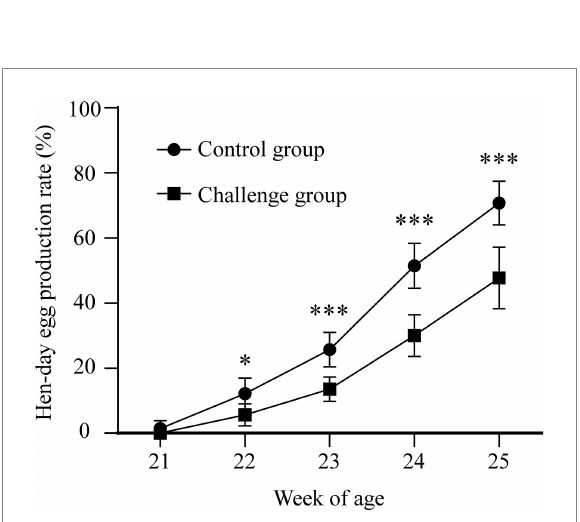
FIGURE 4 Viral shedding was detected in both oral and cloacal swab samples. Oral and cloacal swab samples were collected at 3, 6, 9, and 12 dpi, and RT-qPCR was used to measure the level of viral shedding in these samples. Statistical differences between two groups were assessed by the Student’s t -test Statistical significance was defined as follows: ** p <